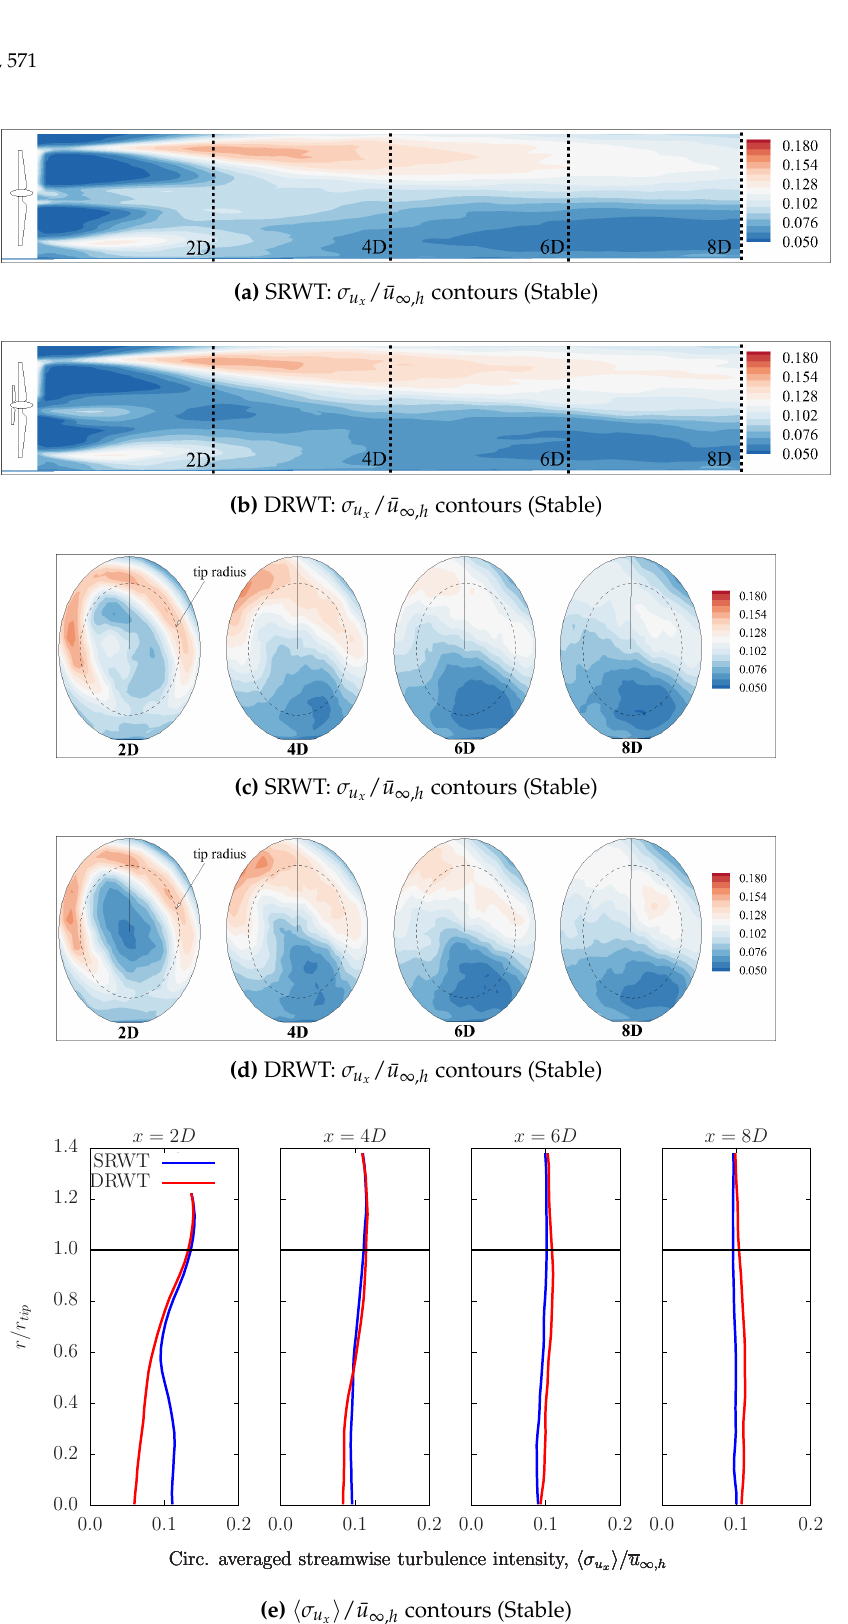
Figure 12. Comparison between SRWT and DRWT of normalized streamwise turbulence intensity, σ u / ¯ u ∞ , h : ( a , b ) on the x - z plane passing through the rotor hub; ( c , d ) on cross-stream ( y - z ) planes; and x ( e ) circumferentially averaged values at four downstream locations ( x / D = 2, 4, 6, and 8) for the stable ABL